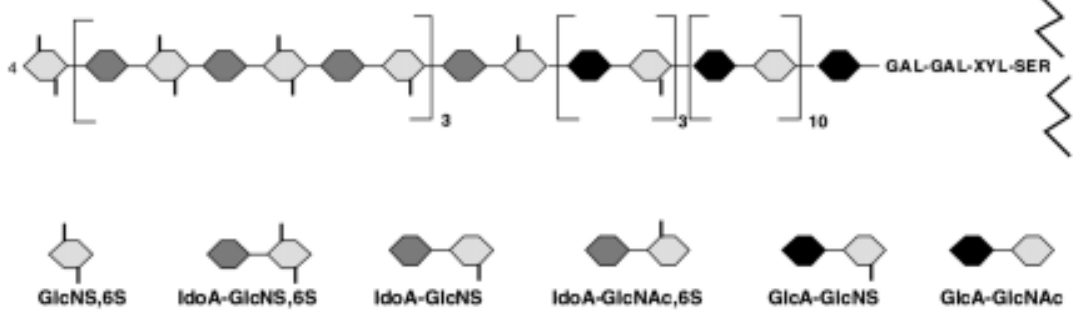
Figure 6 - Proposed structure of heparan sulfate from the mollusc Anomantidae sp. IdoA, a -L-Iduronic acid; GlcA, ß-D- glucuronic acid; GlcN, a -D-glucosamine; GlcNAc, a -D-N-acetylglucosamine; S,